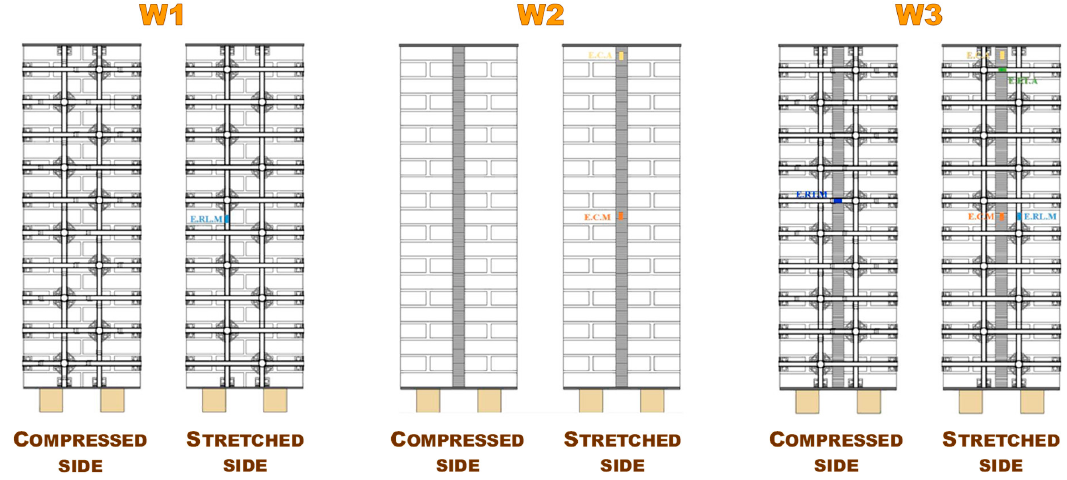
Figure 33. Strengthening schemes of Specimens W1, W2, and W3.